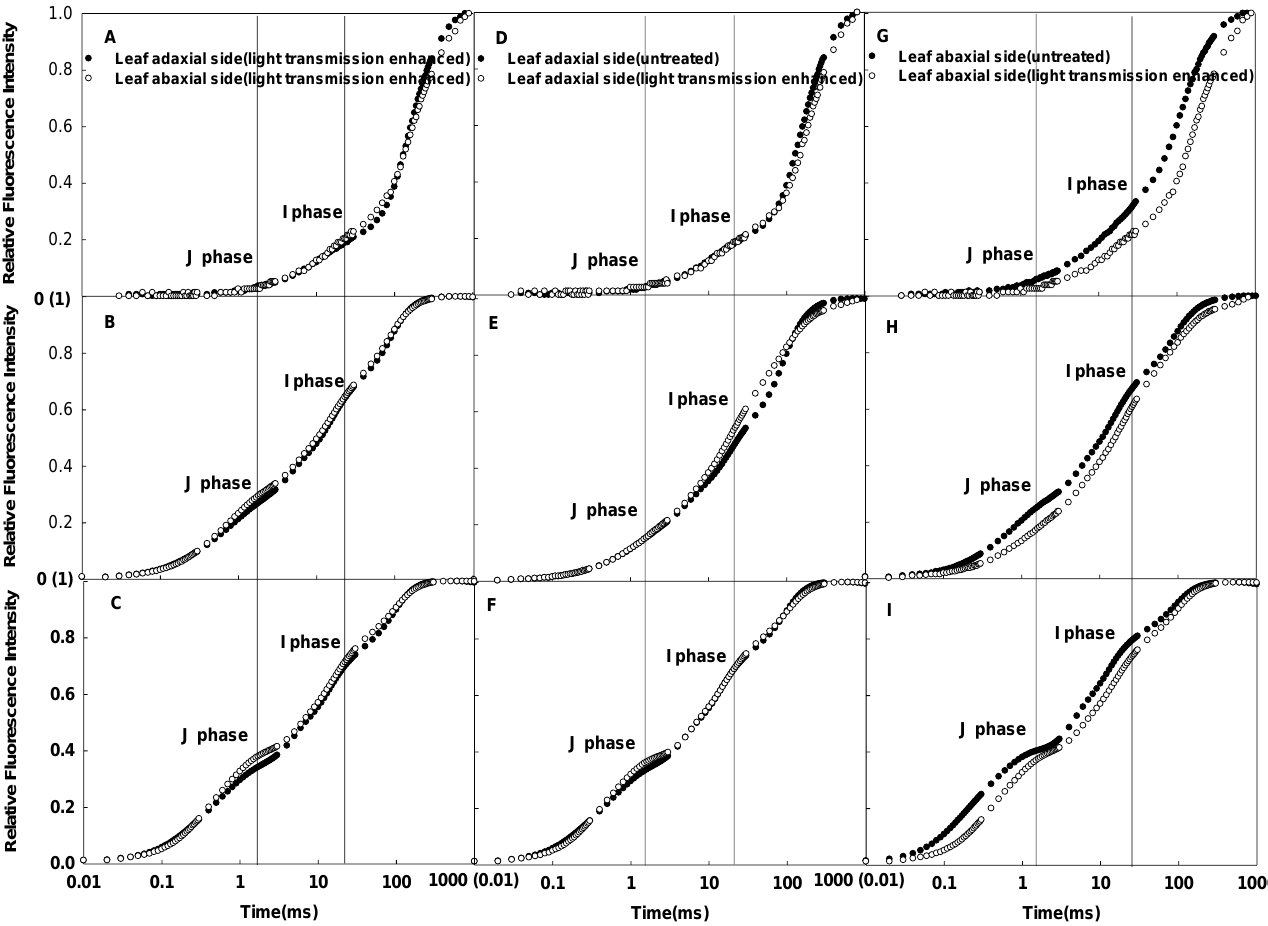
Figure 3. Differences in the CFI curves of the adaxial and abaxial sides of sunflower after enhancing light transmission under various pulsed light intensities ( A – C ); effects of enhanced light transmission on the CFI curves of the adaxial side of sunflower leaves under various pulsed light intensities ( D – F ); effects of enhanced light transmission on the CFI curves of the abaxial side under various pulsed light intensities ( G – I ). The pulsed light intensities were 200 ( A , D , G ), 1000 ( B , E , H ), and 3000 ( C , F , I ) µmol·m −2 ·s −1 .